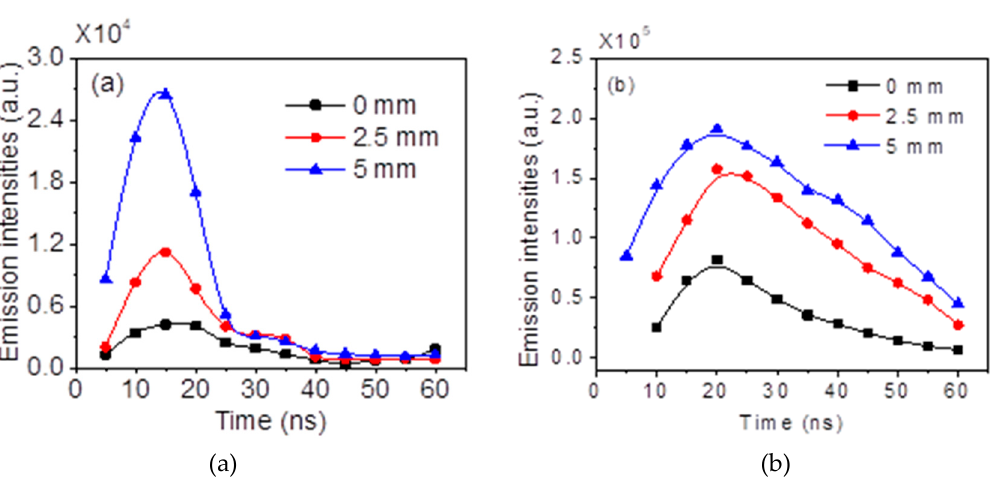
Figure 6. Spatiotemporal distribution of the emission intensities: ( a ) 𝑁 (cid:2870)(cid:2878) (B (cid:2870) 𝛴 (cid:3048)(cid:2878) → X 2 Σ g + , 0–0, 391.4 nm); ( b ) N 2 (C 3 Π u → B 3 Π g , 2–5, 394.3 nm).